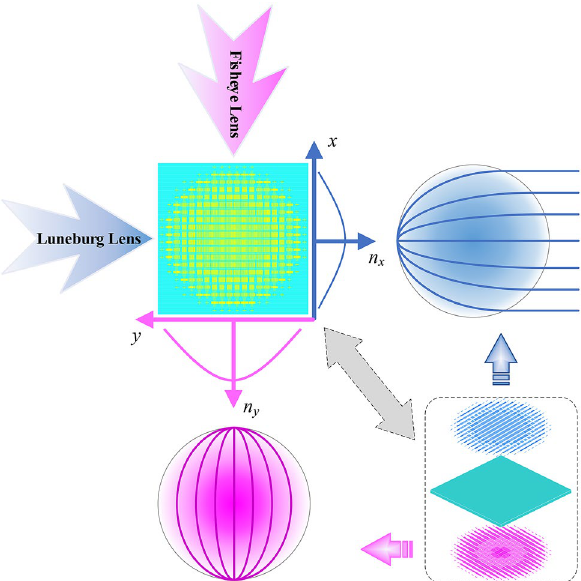
Figure 8. Illustration of the bifunctional Luneburg-fisheye lens synthesized by the proposed anisotropic cells.